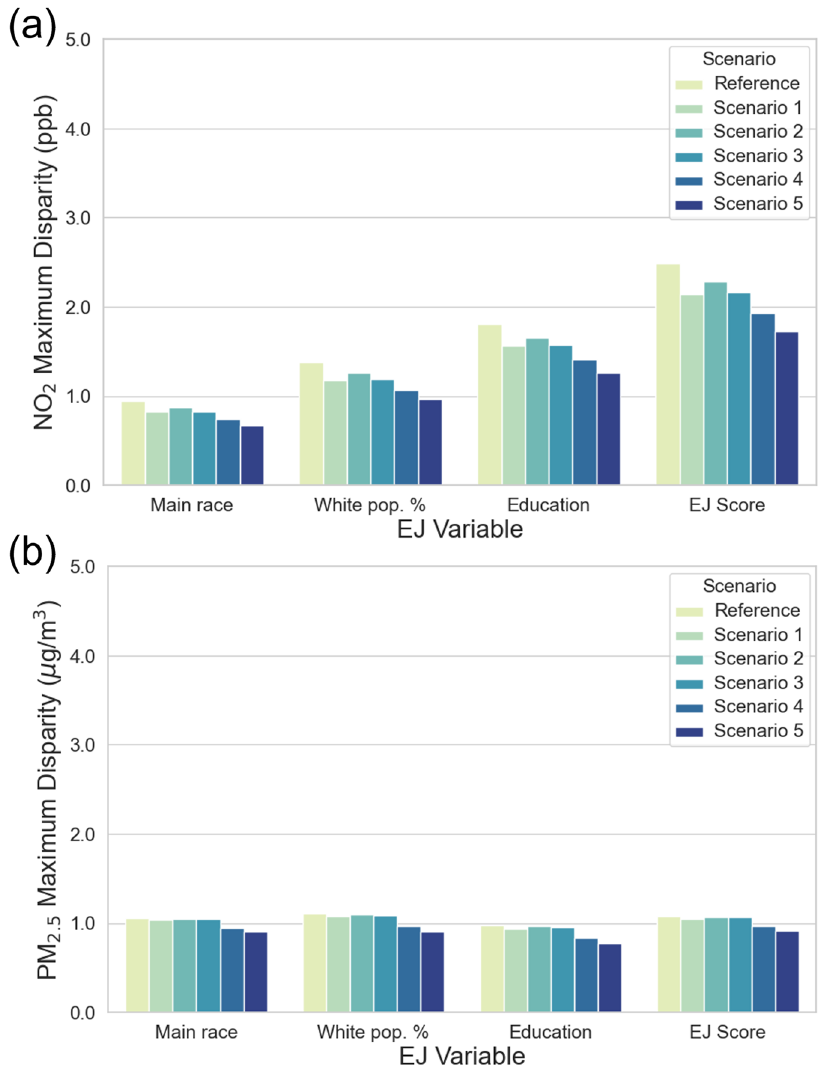
Fig. 8 The modeled maximum disparity in concentration. a Maximum disparity for NO x and b maximum disparity for PM 2.5 . The maximum disparity is de fi ned as the average concentration difference between the group that is exposed to the highest concentration of a pollutant and the group that is exposed to the lowest concentration. Lower disparity represents a lower degree of disproportional exposure to air pollutants. Main race means the racial grouping with the highest population percentage within a given census